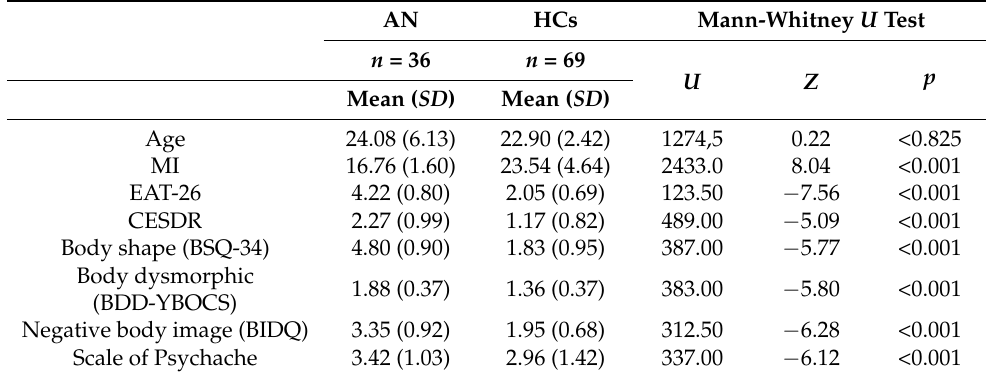
Table 1. Summary of group characteristics and results of the two-way analysis of variance.